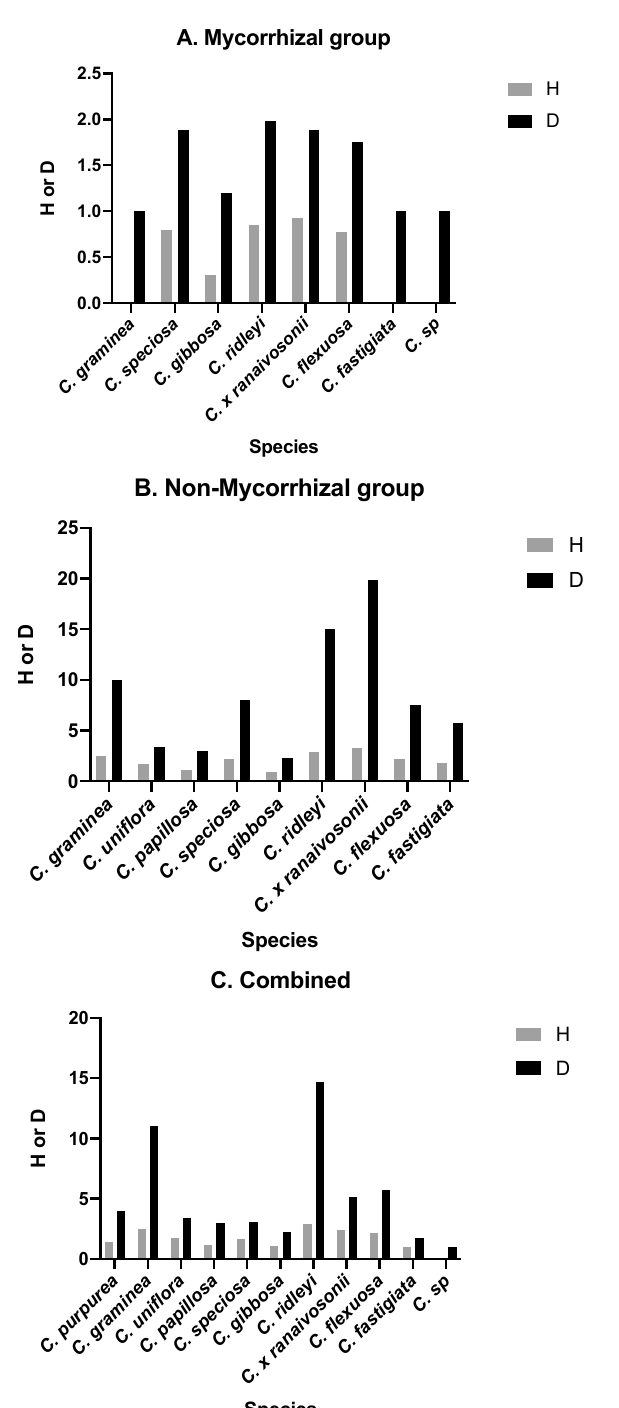
Figure 5. Diversity indices, Shannon’s (H) and Simpson’s (D), of mycorrhizal fungi ( A ), non-mycorrhizal fungi ( B ) and Total ( C ) of eleven Cynorkis species (non-mycorrhizal values not counted for C. purpurea ).